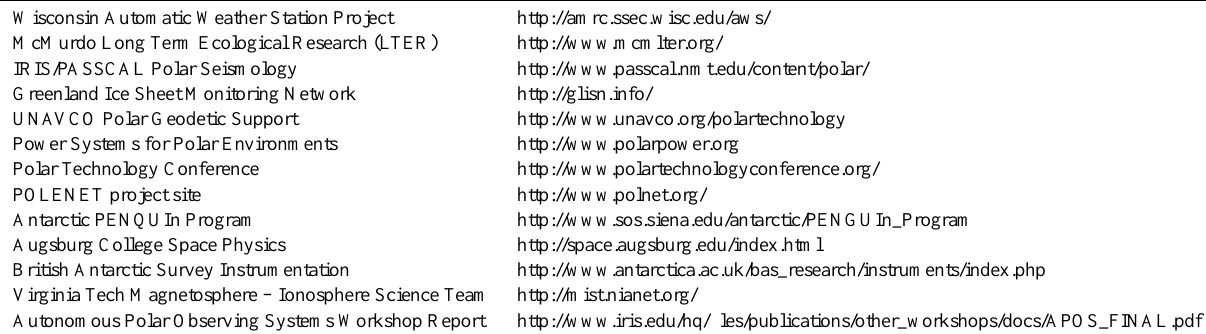
Table A1. Web resources for autonomous polar system